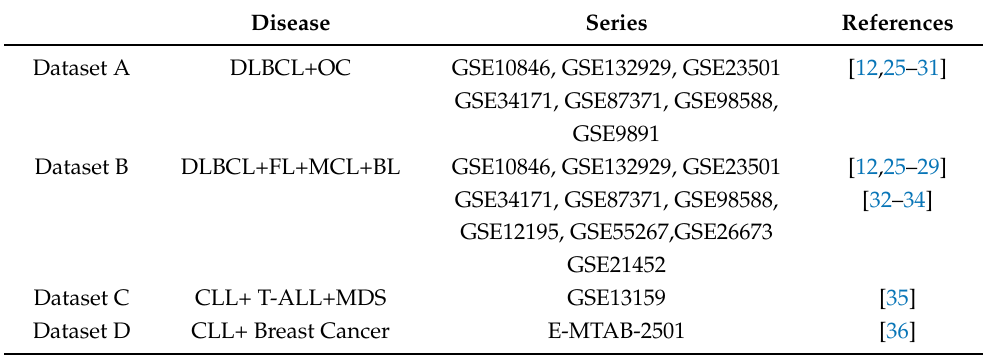
Table 3. Description of the dataset.